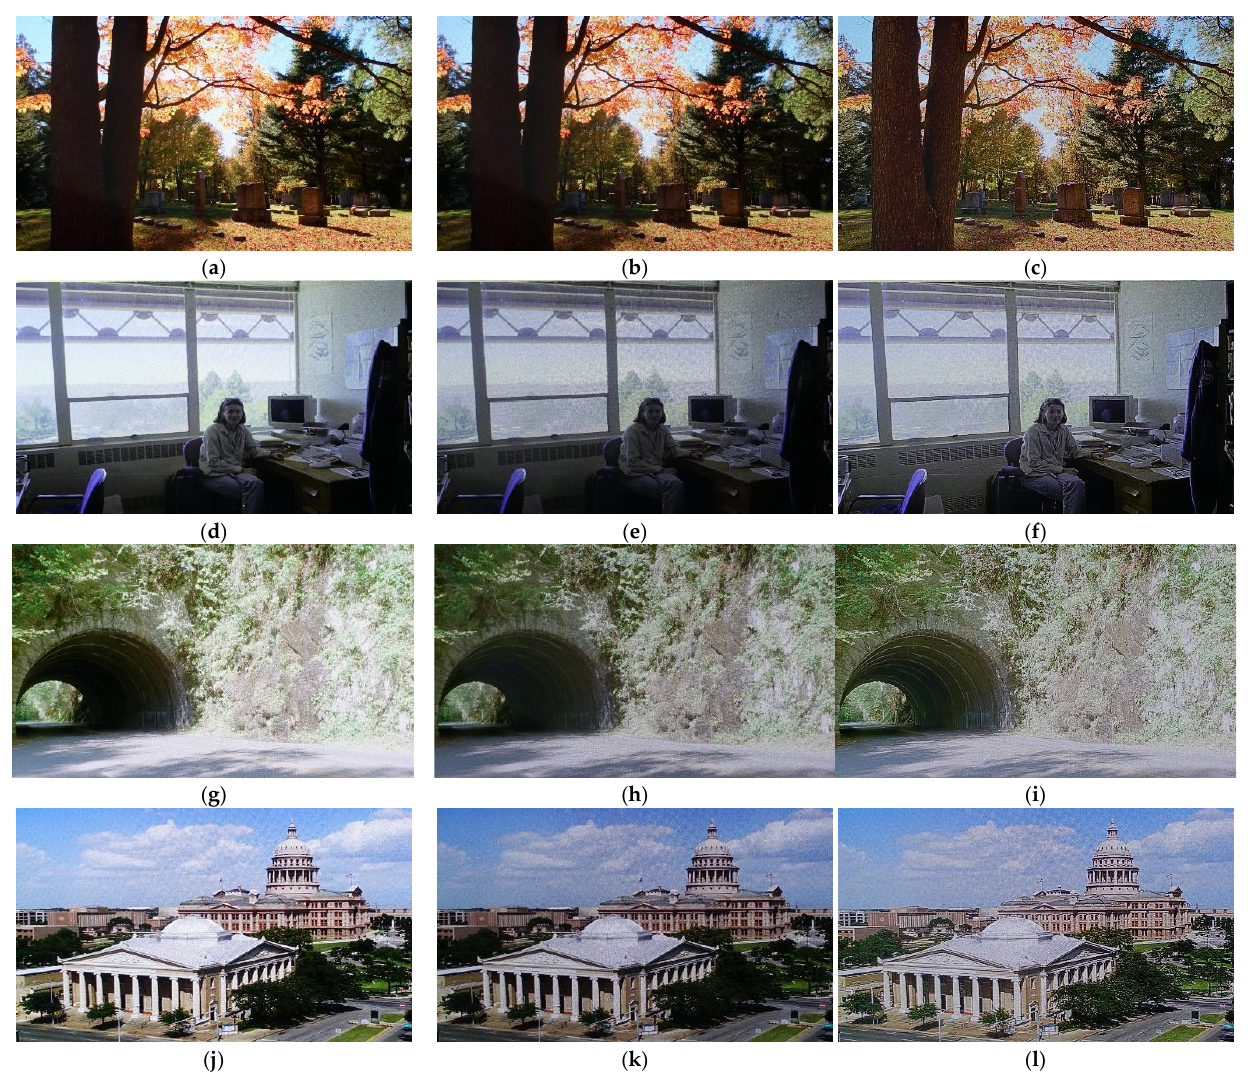
Figure 5. Comparison of normal mode, LGC-DVS and proposed method: ( a , d , g , j ) normal mode (display backlight = 200); ( b , e , h , k ) LGC-DVS; ( c , f , i , l ) proposed method. ( a ) Average luma: 86.97; ( b ) average luma: 87.89 display power saving: 36.21%; ( c ) average luma: 114.11, display power saving: 37.13%; ( d ) average luma: 125.78; ( e ) average luma: 125.13, display